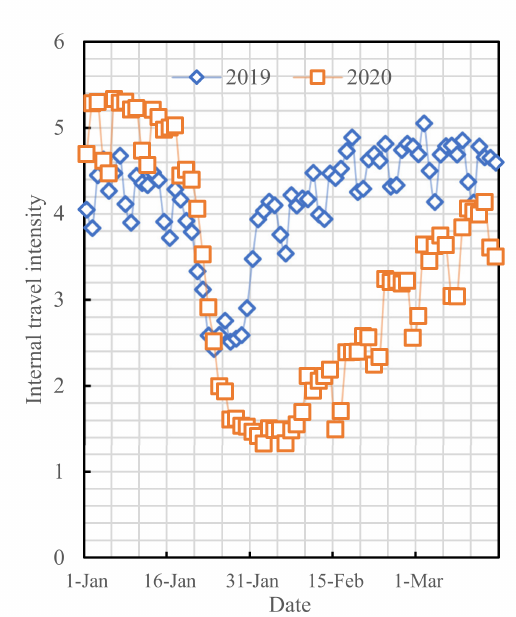
Figure 3. Intracity activity intensities within Changsha in the same period of 2020 versus